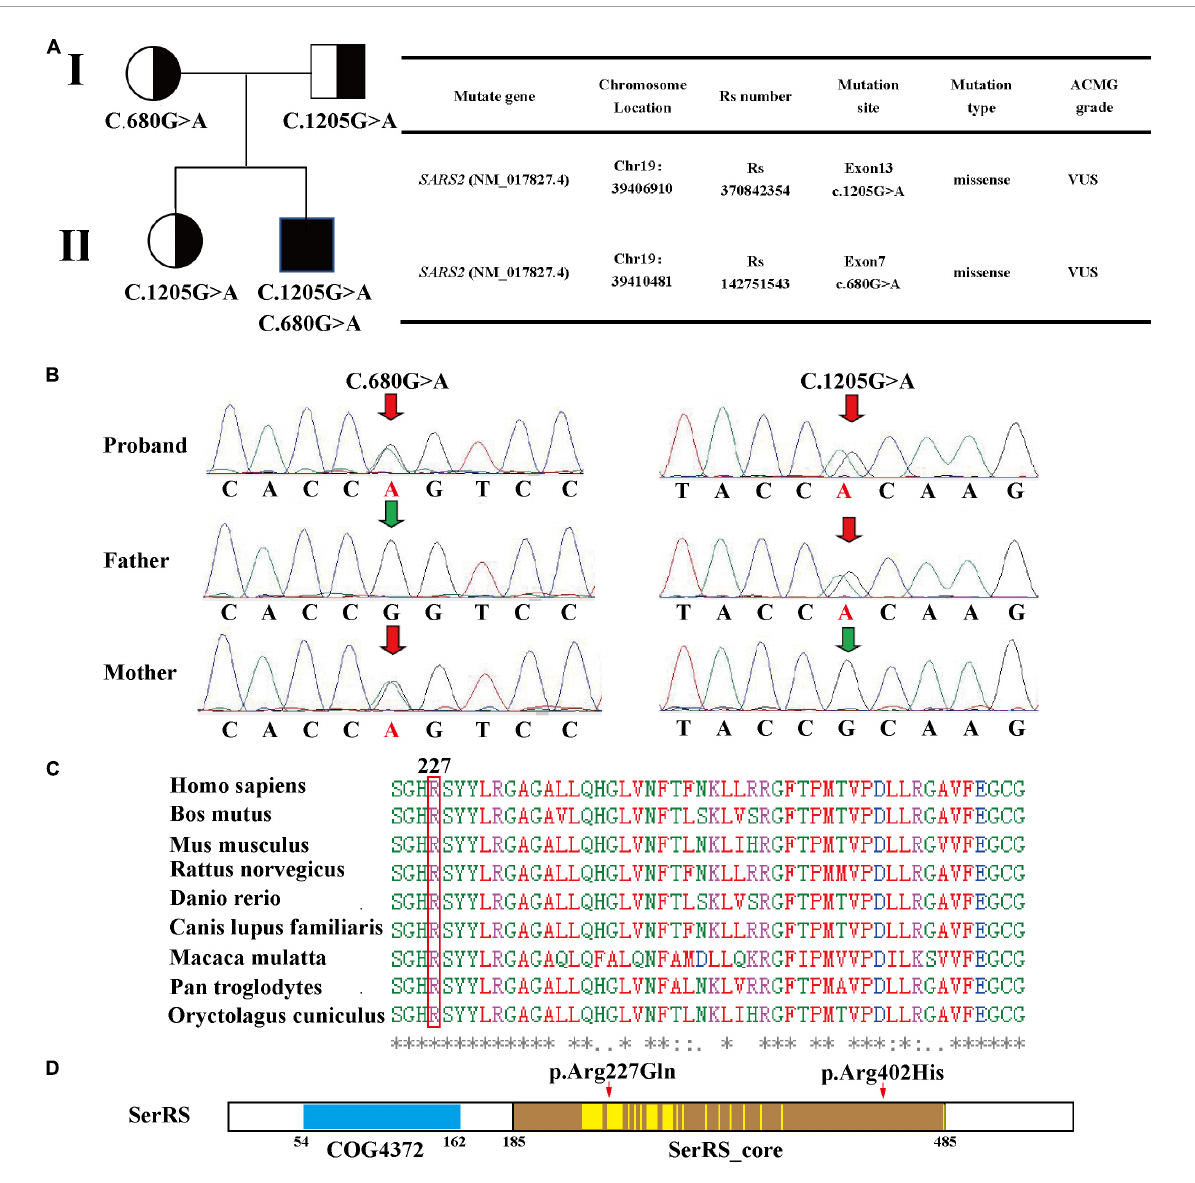
FIGURE2 (A) Family pedigree, mutation sites, and ACMG grade based on whole-exome sequencing. (B) Sanger sequencing validation of the patient. (C) Multiple sequence alignment of 227-Arg using T-coffee. (D) Region analysis of seryl-tRNA synthetase 2 using NCBI, two conserved domain is identified: COG4372 (54–162) and SerRS_Core (185–485). According to the dual-mode recognition of SerRS, 36 of the residues are located in the dimer-interface (marked in yellow highlight), and 227-Arg is one of these